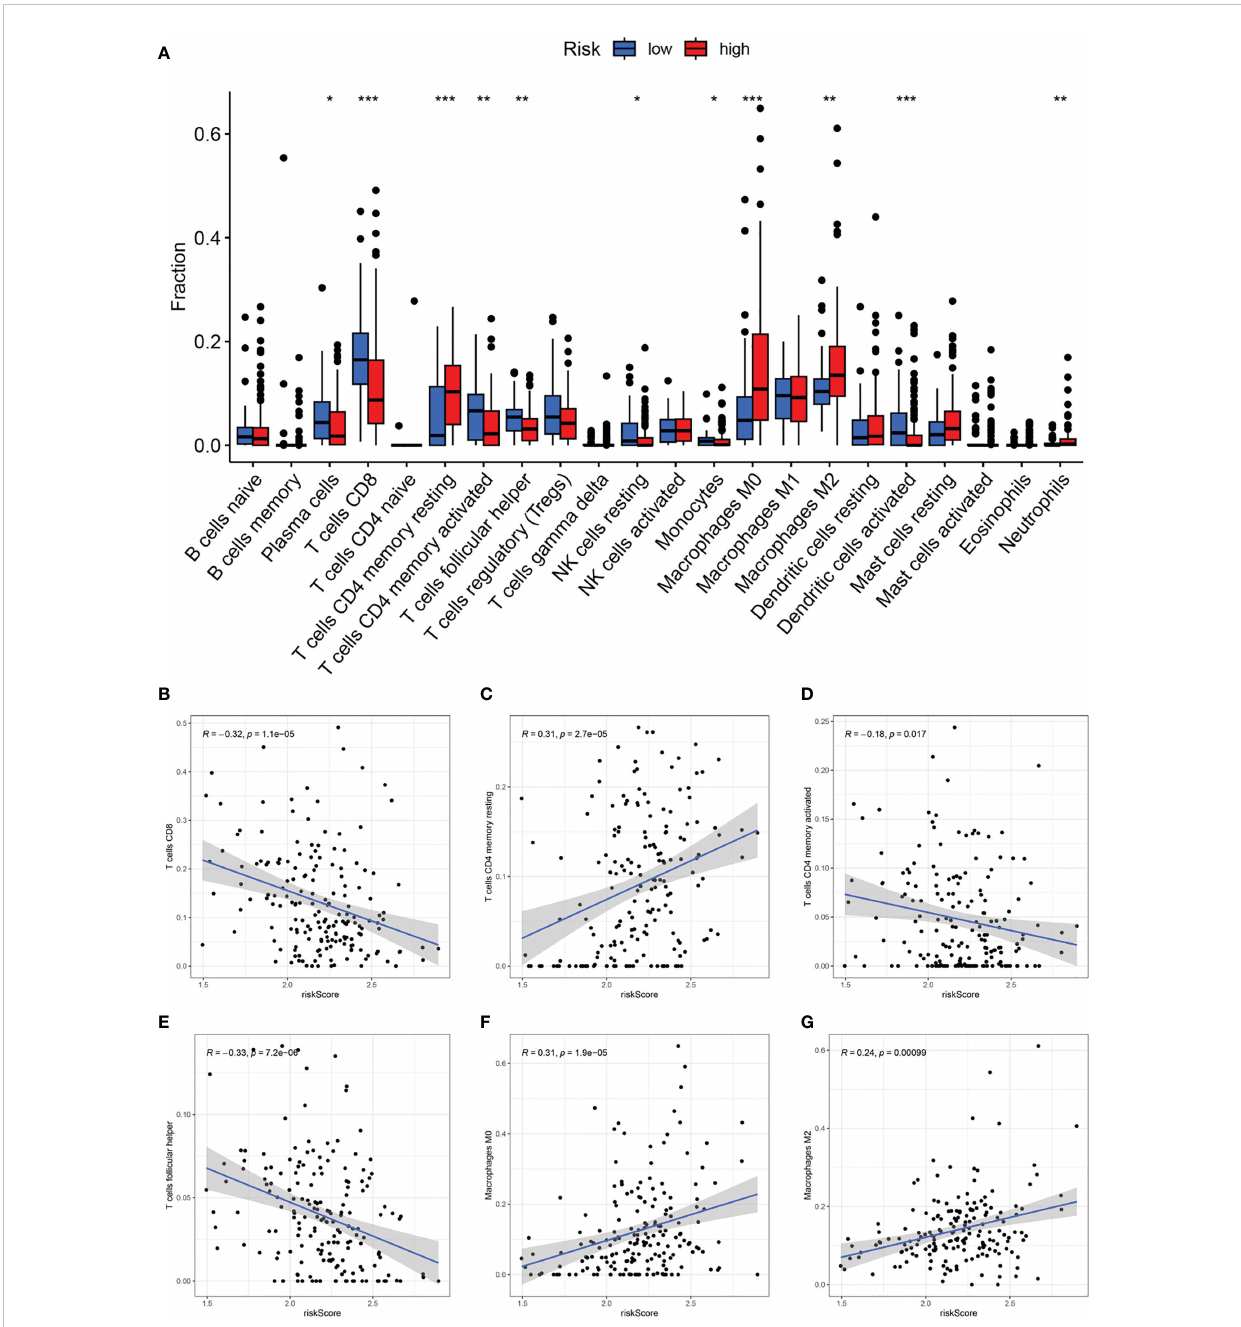
FIGURE 9 CAF-signature related immune landscapes. (A) The bar graph of difference in composition of the 22 types of immune cells between two CAF-risk subtypes, *p< 0.05, **p< 0.01, and ***p< 0.001. (B-H) The correlation between the CAF-riskScore and (B) CD8 T cells, (C) resting CD4 memory T cells, (D) activated CD4 memory T cells, (E) follicular helper T cells, (F) M0 Macrophages and (G) M2